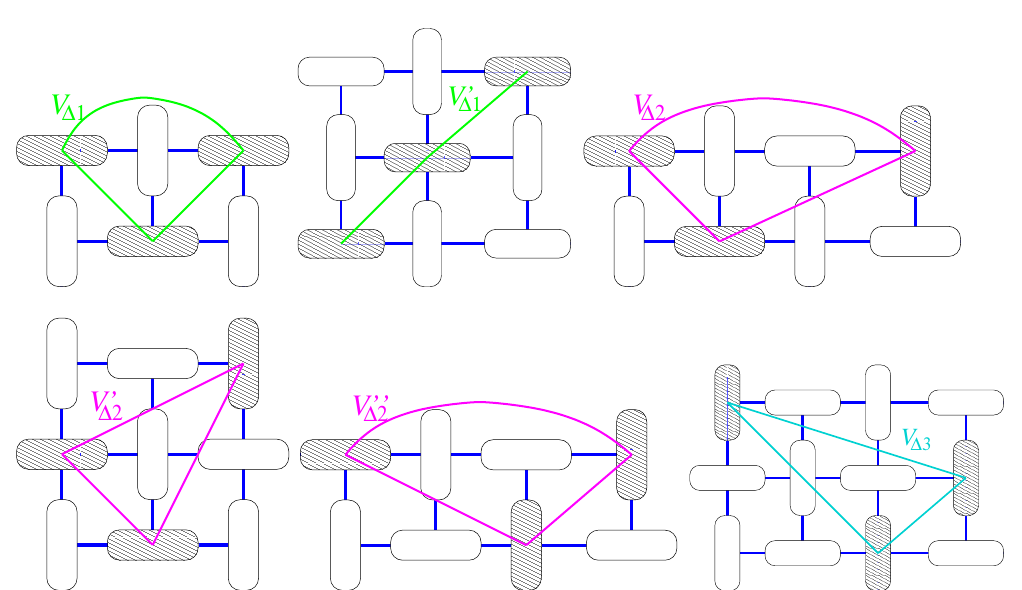
Figure 5: A schematic representation of effective three-particle interactions between triplons.